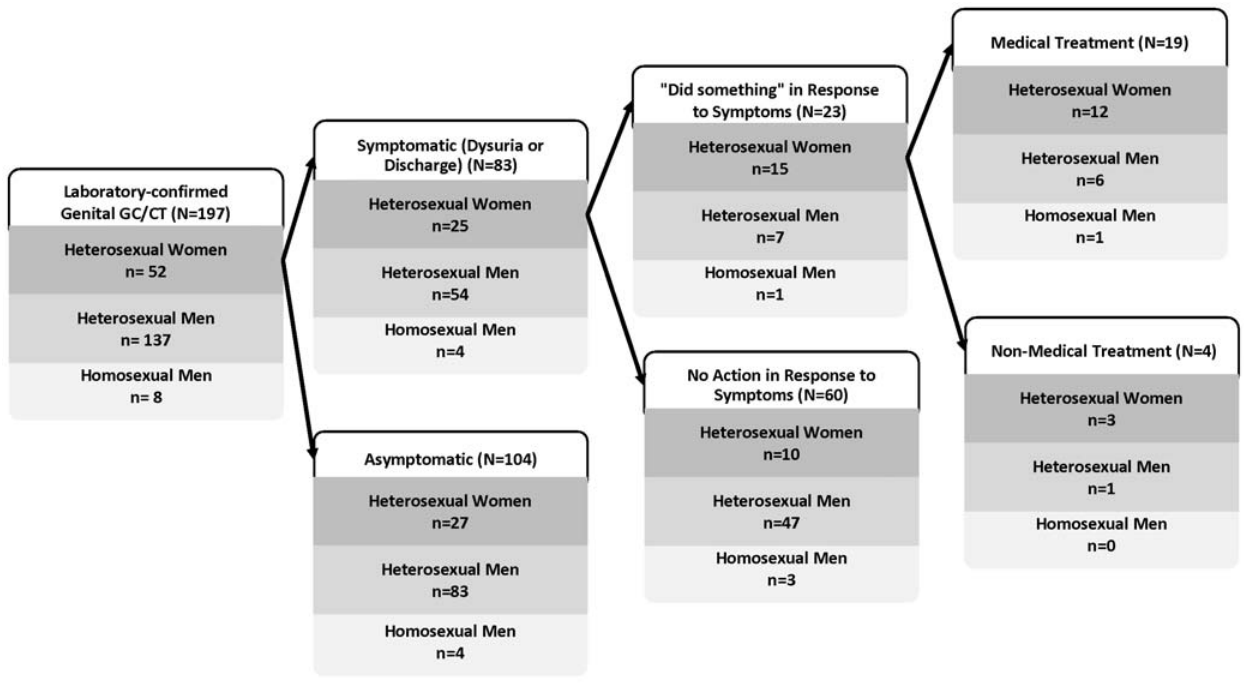
Figure 1. Pre-enrollment Treatment Outcomes Among Men and Women with Genital Gonorrhea and/or Chlamydia; Lima, Trujillo and Chiclayo, Peru 2003–05.